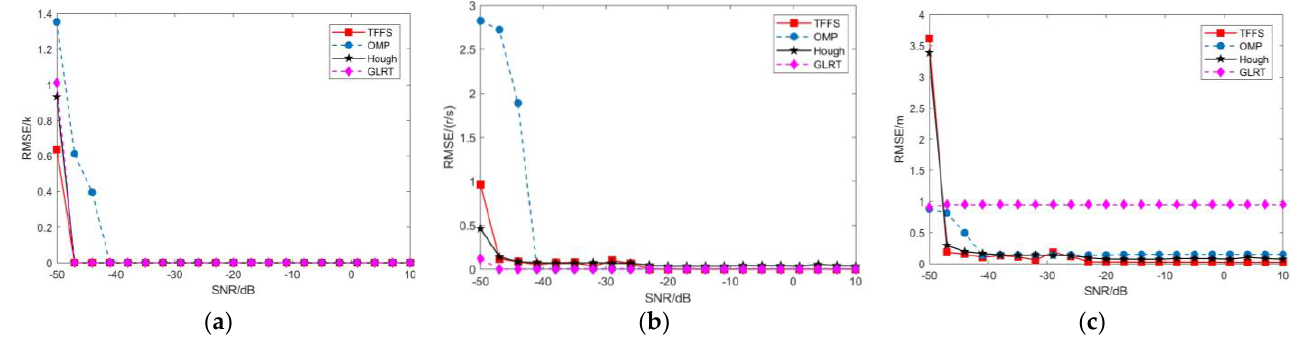
Figure 16. The parameters estimation RMSEs: ( a ) estimation RMSE of K ; ( b ) estimation RMSE of fr ; ( c ) estimation RMSE of L. ( c ) estimation RMSE of L